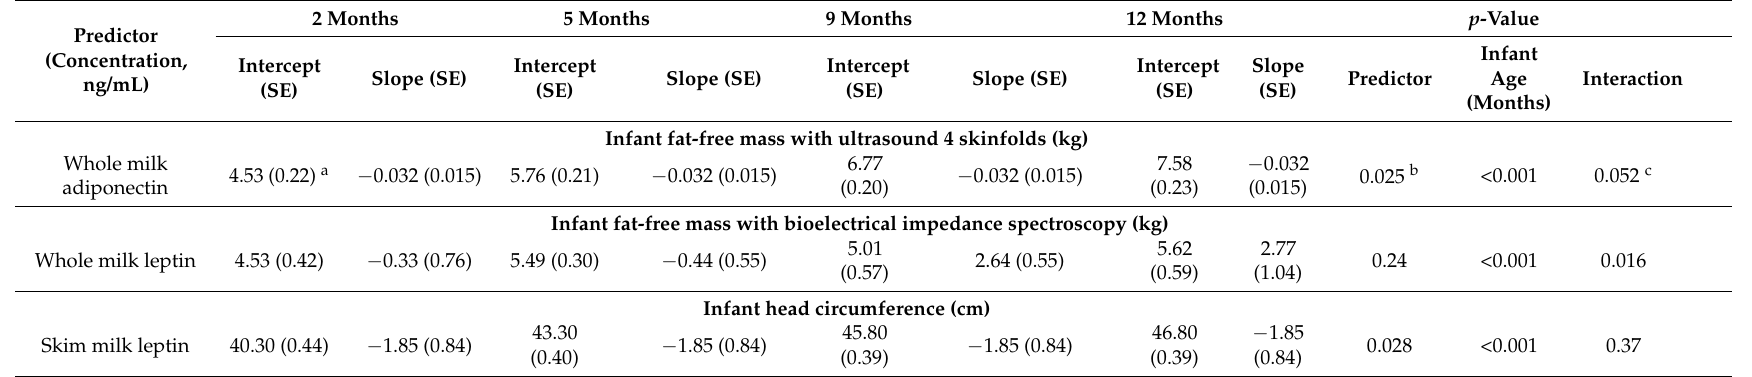
Table A2. Associations between concentrations of human milk adipokines and infant characteristics.